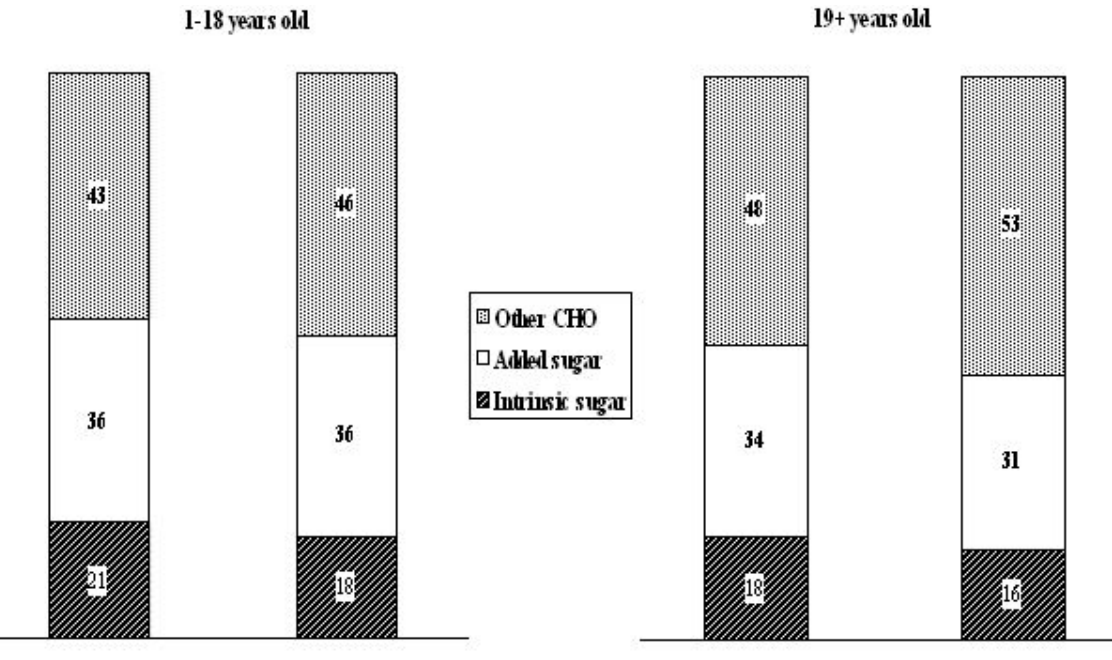
Figure2. Comparison of the contribution (%) of individual carbohydrates to the total carbohydrate intakes between the NHANES I and III by age